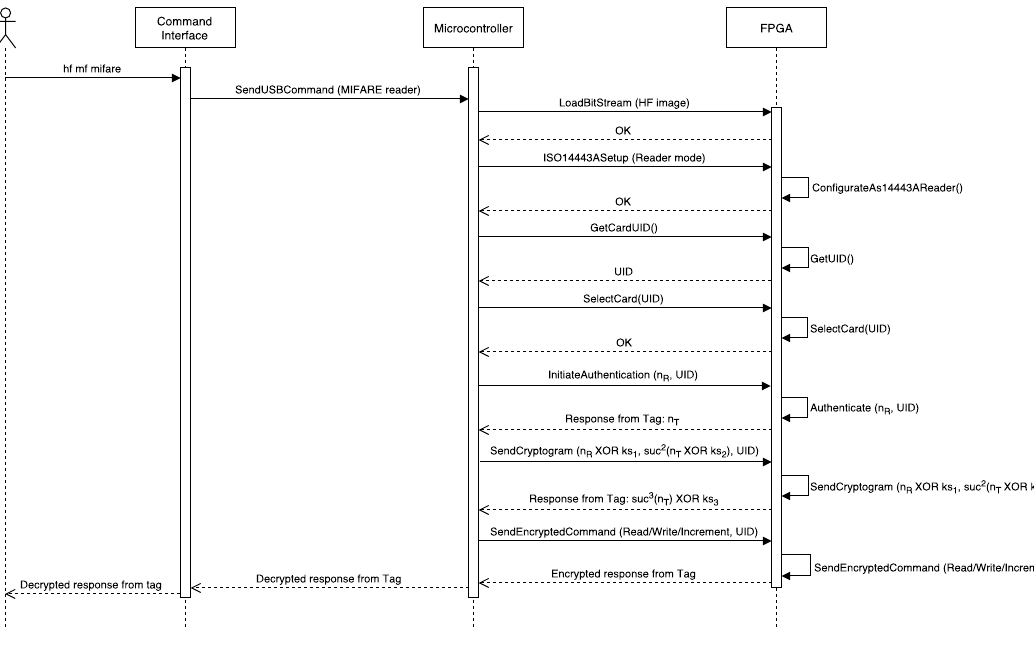
Figure 18. Authentication process of a MIFARE card in Proxmark